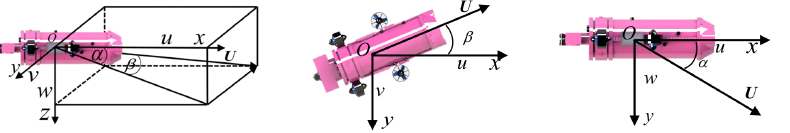
Figure 8. Left diagram shows hydrodynamic angles of the Shark-AUV; the middle diagram shows the oblique motion of the AUV in the horizontal plane; the right diagram shows the oblique motion of the AUV in the vertical plane.